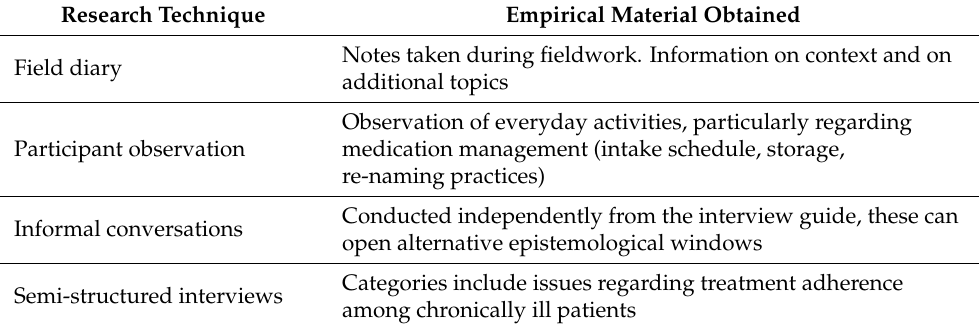
Table 1. Research techniques.